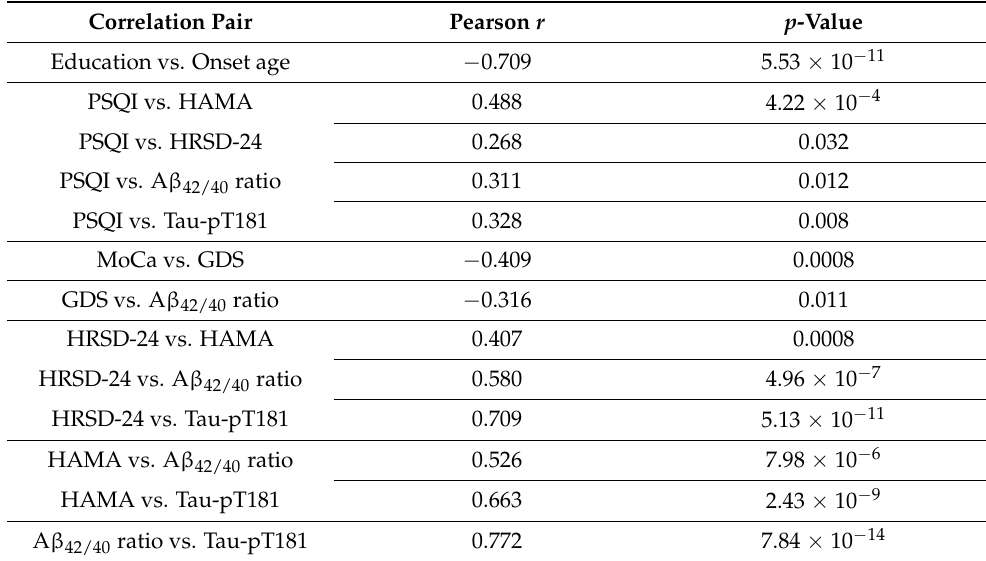
Table 3. Pearson Correlation Coefficient.